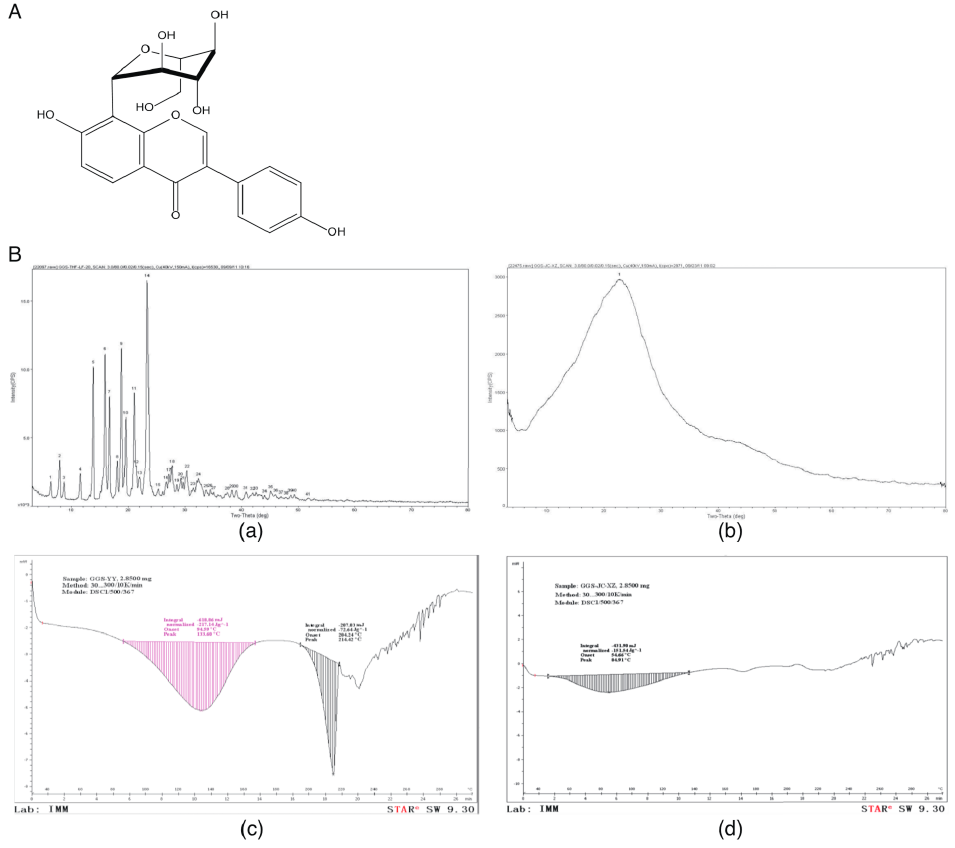
Figure 1. Structure of puerarin-V and differences in crystal characterization between puerarin-V and puerarin. ( A ) The chemical structure of puerarin-V. ( B ) Representative images of powder X-ray diffraction (PXRD) of puerarin-V ( a ) and puerarin ( b ); representative images of differential scanning calorimetry (DSC) of puerarin-V ( c ) and puerarin ( d ).